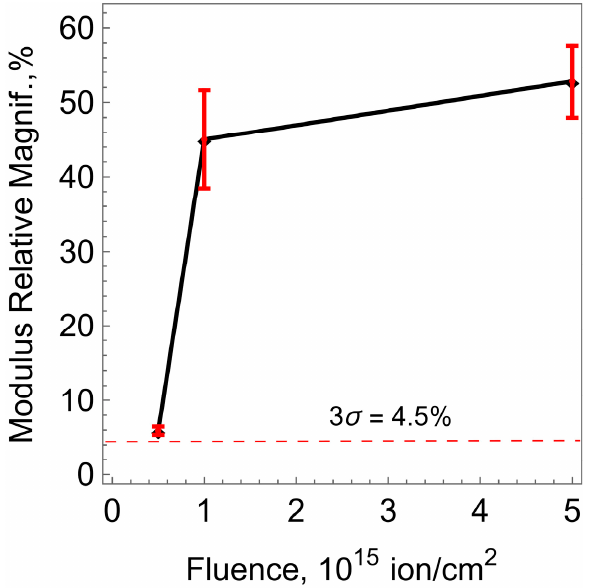
Figure 8. Increase in the effective modulus relative to the initial elastic modulus of the sample as a function of the plasma treatment fluence.